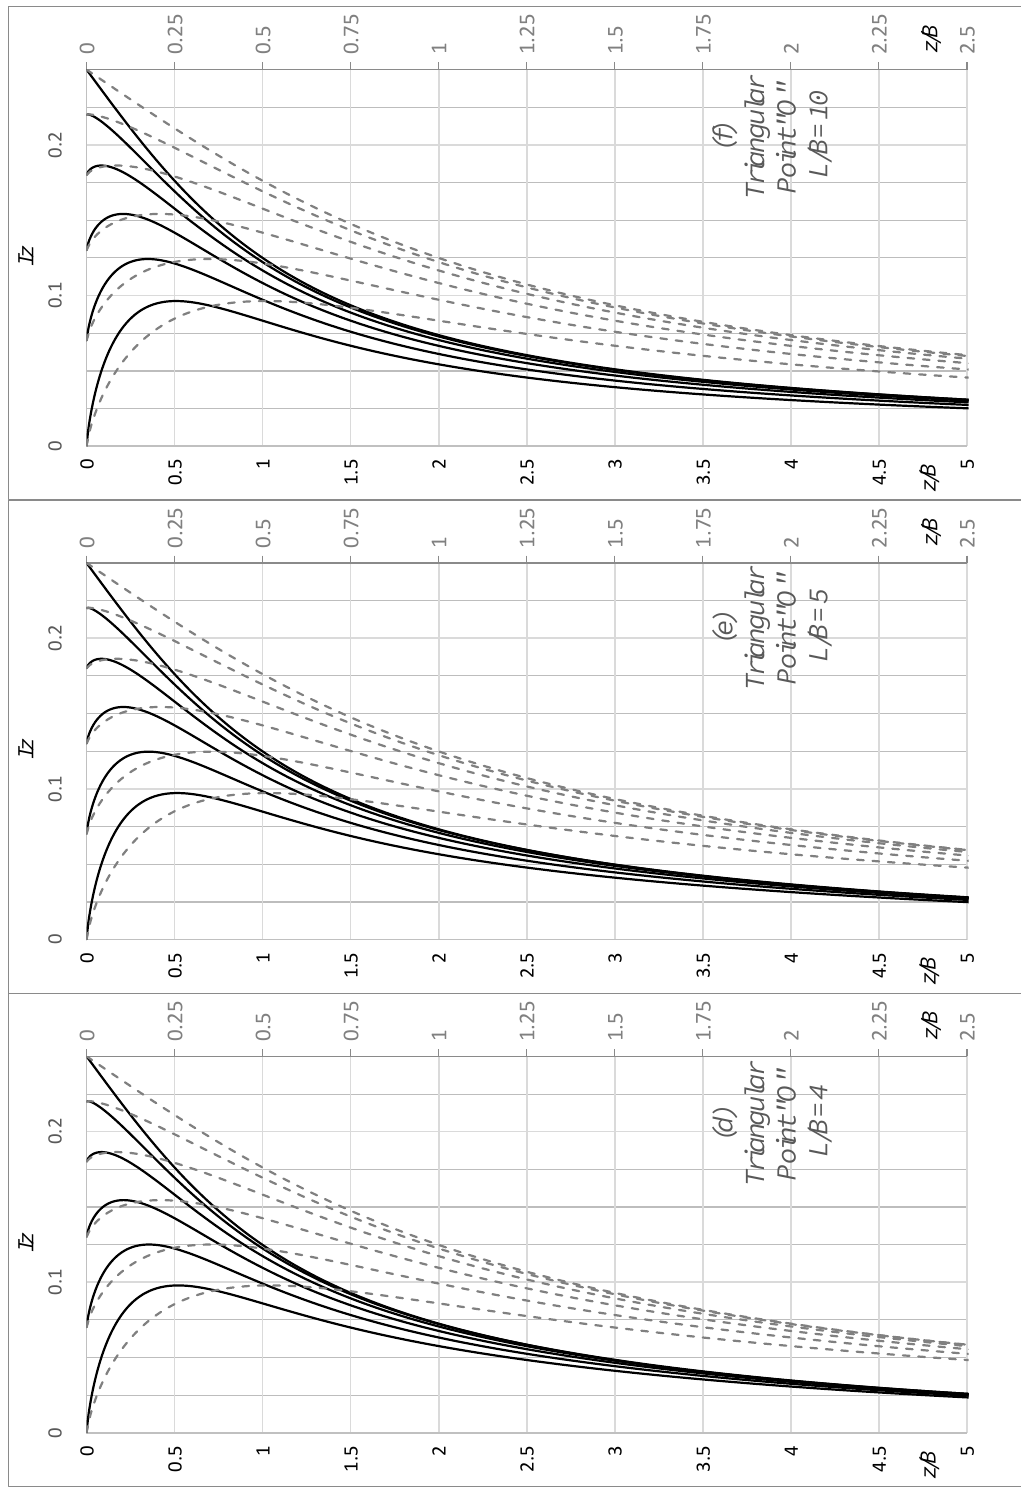
Figure 6. I z versus normalized depth charts referring to point “O” of the triangular embankment loading of Figure 8b for various ν values; ν ranges from 0.5 to 0 (left to right) with 0.1 interval.